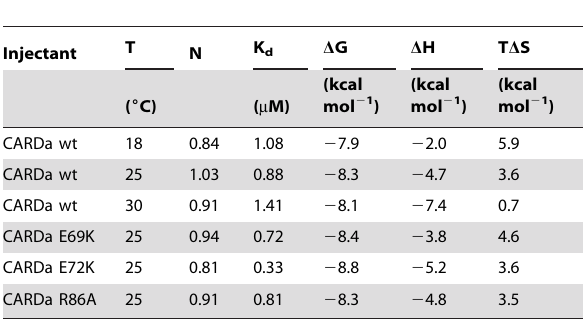
Table 1. Thermodynamic parameters for the CARDa-CARDb